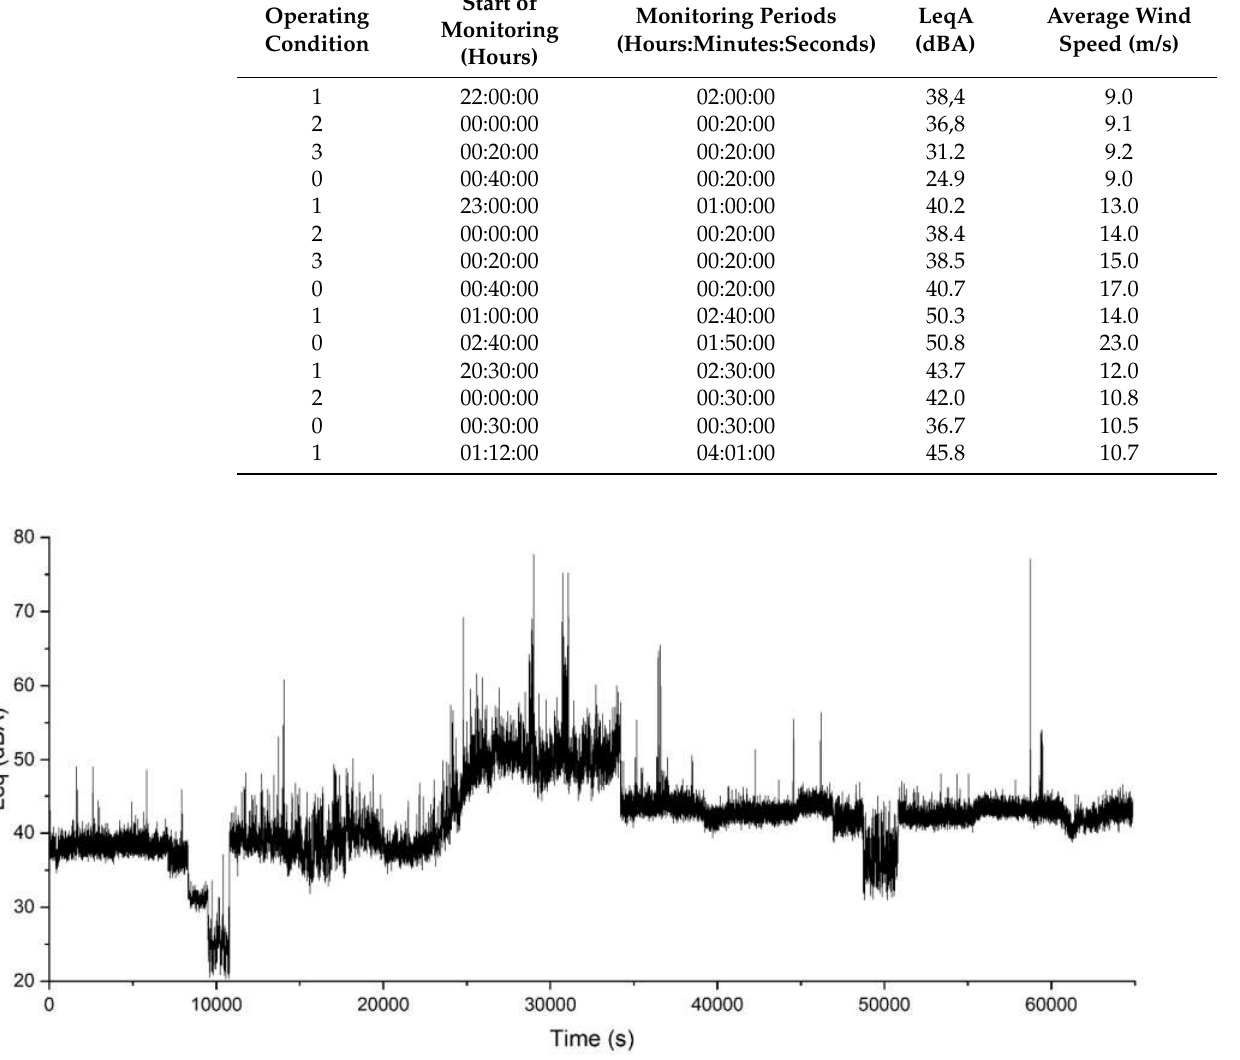
Figure 3. Time history of the sound pressure level measured in situ, in different operating conditions. Table 1. Summary of the acoustic measurements carried out in time intervals representative of different operating conditions. The measurements refer to several days of monitoring (Figure 3). 0 = all turbines off, 1 = all turbines on, 2 = one turbine off, 3 = two turbines off.